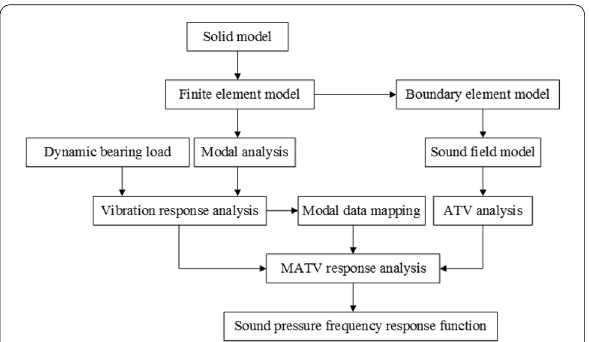
Figure 1 Radiated noise analysis process of gearbox